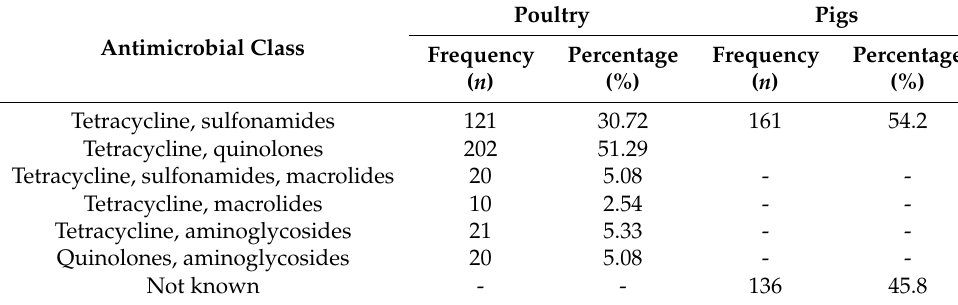
Table 2. Antimicrobial classes commonly used in livestock